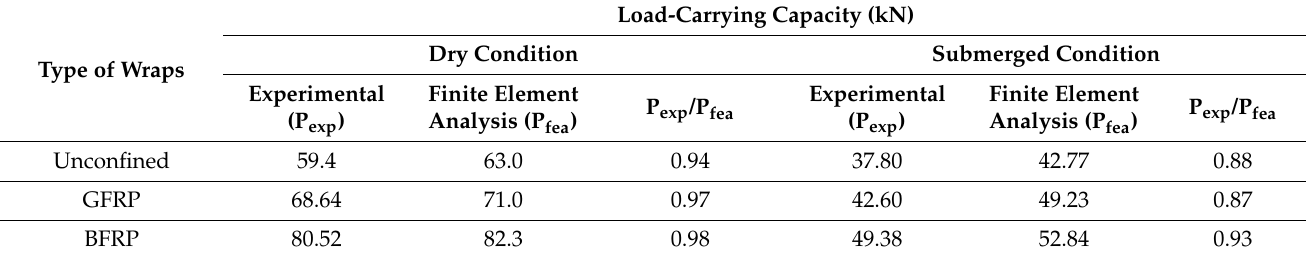
Table 9. Uplift capacity – Experiment vs